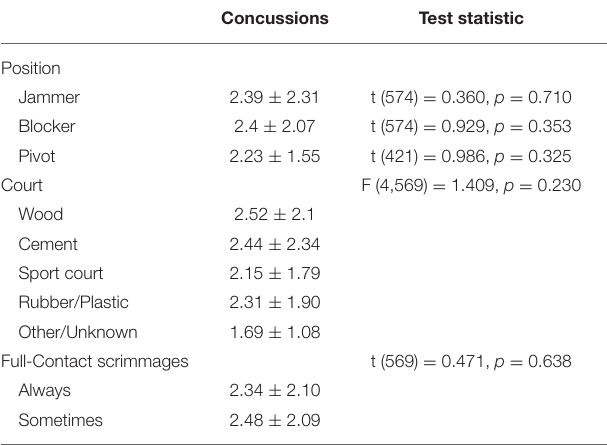
TABLE 2 | Concussions by bout characteristics.